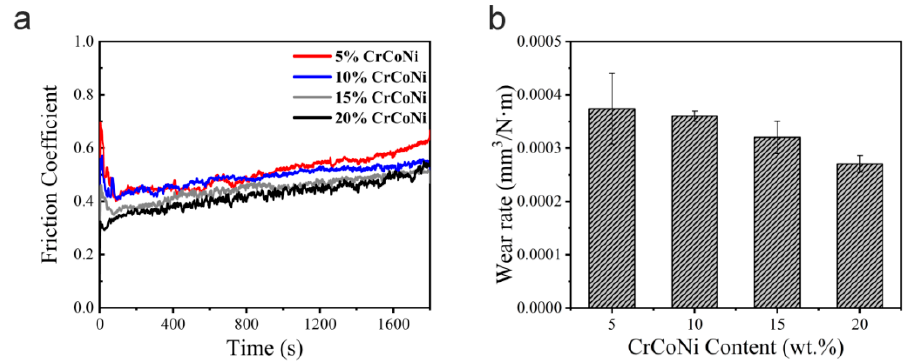
Figure 8. The friction properties of the composites with the different CrCoNi content. ( a ) The coef- ficient of friction curves of the composites; ( b ) the average wear rate of the composites.